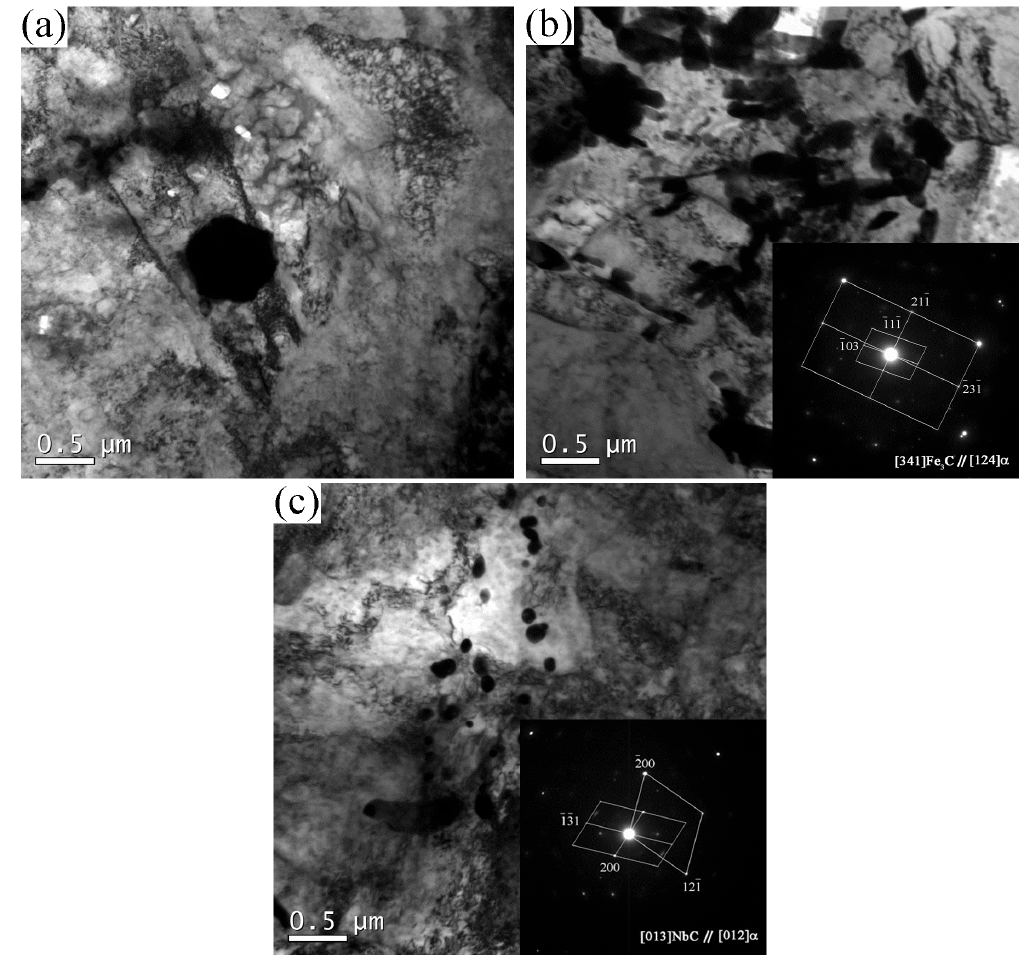
Figure 7. TEM images for the three scales particles in specimens: ( a ) Ti-oxide; ( b ) cementite decomposed from M/A island (insert: diffraction pattern); ( c) MC carbides precipitated in matrix (insert: diffraction pattern).